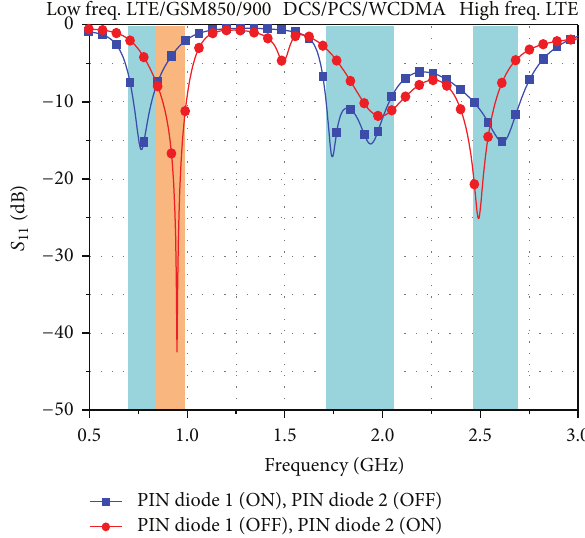
Figure 9: Simulated 𝑆 11 of the proposed antenna.